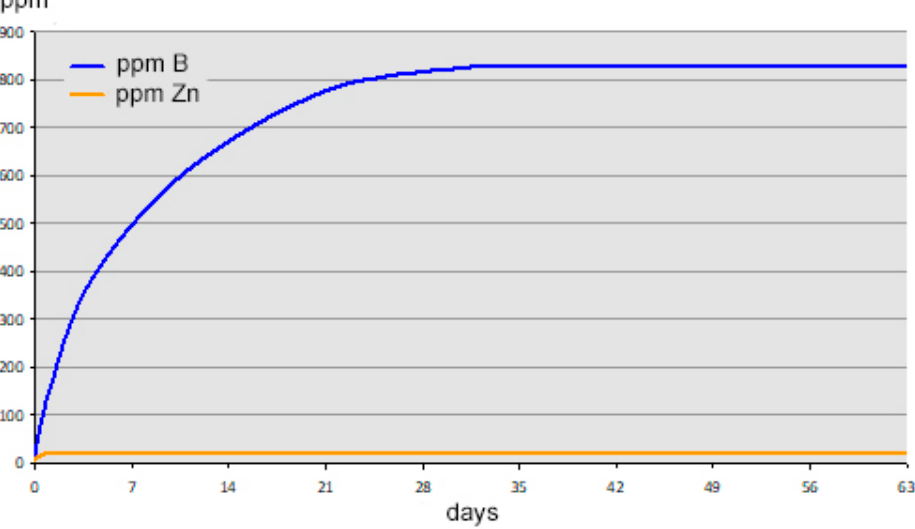
Figure 3. Plot of boron and zinc concentrations in solution for 10 wt% of zinc borate ZnB 3 O 4 (OH) 3 . ZnB 3 O 4 (OH) 3 was found to be a stable phase when a 10 wt% aqueous suspension was maintained at the boiling point under reflux for prolonged periods of time. However, more dilute slurries were observed to convert to other phases. For example, continuous boiling under reflux of a 5 wt% aqueous suspension of ZnB 3 O 4 (OH) 3 (2ZnO · 3B 2 O 3 · 3H 2 O) for one month resulted in complete conversion to the crystalline phase 6ZnO · 5B 2 O 3 · 3H 2 O. This is represented using oxide formulas by Equation (3) as the structural formula of 6ZnO · 5B 2 O 3 · 3H 2 O is not currently known. This phase was first reported by Lehmann, et